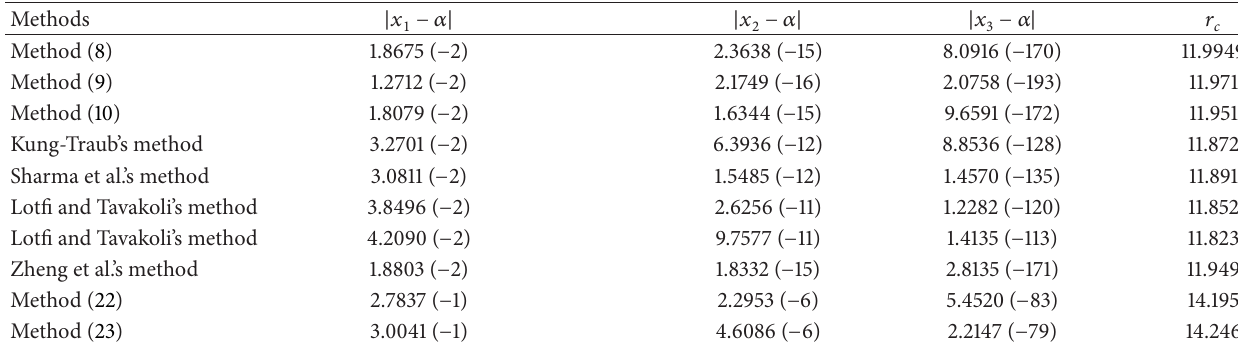
2 +𝑥 cos 𝑥−1 Table 3: 𝑓 3 (𝑥) = 𝑒 𝑥 sin 𝑥 + 𝑥 log (1 + 𝑥),𝑥 0 = 0.6, 𝛼 = 0, 𝛽 0 = 0.01